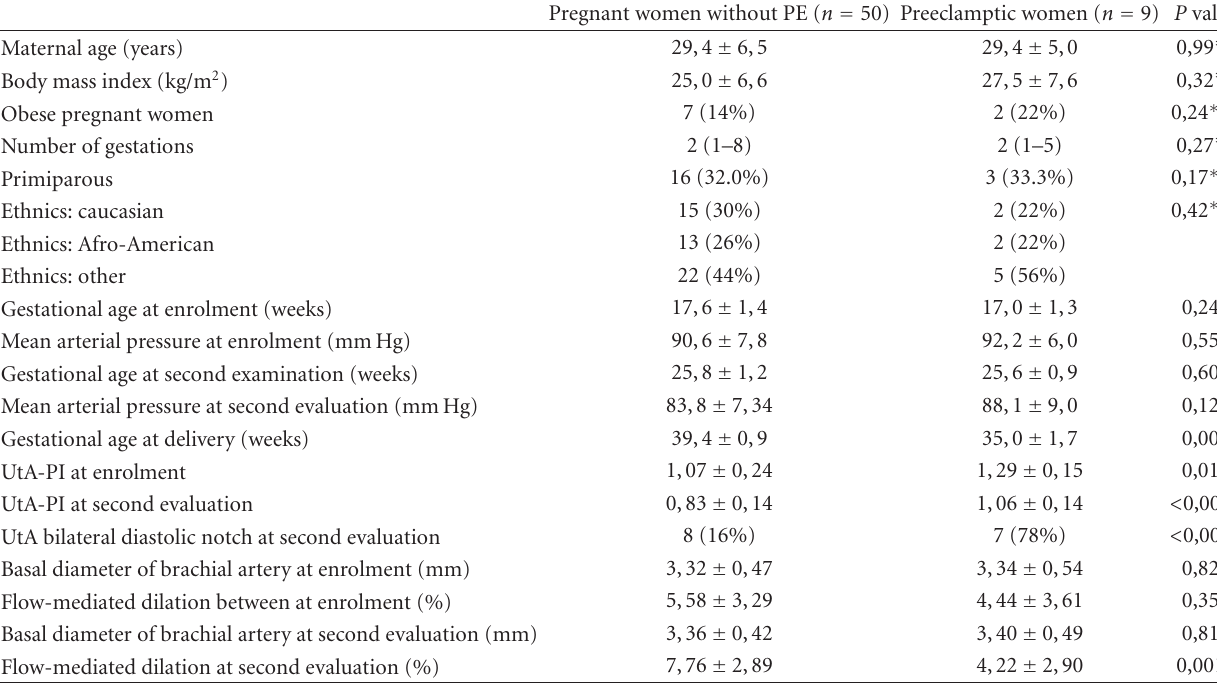
Table 1: Clinical characteristics and ultrasound parameters of pregnant women cohort, according to preeclampsia